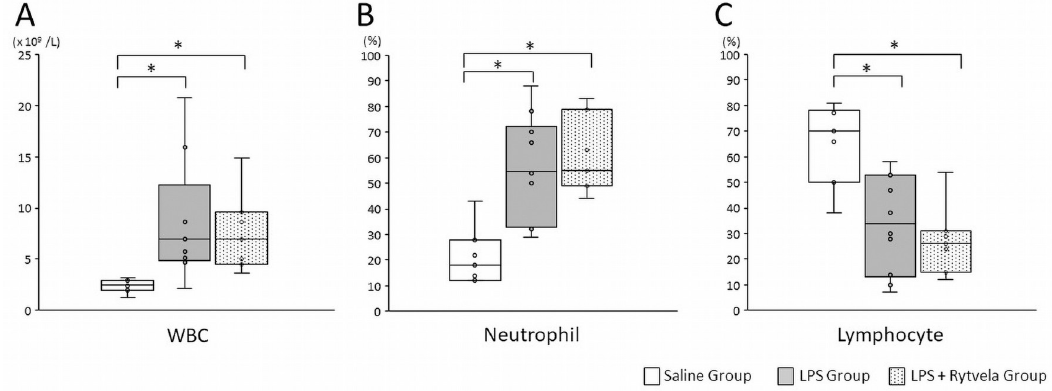
Fig 9. Haematological assessments. Plots show median, 25th, and 75th percentile ranges as boxes and 5th to 95th percentile as error bars. Intra-amniotic injection of LPS affected A , total white blood cell (WBC) counts; B , ratio of neutrophil; C , ratio of lymphocyte from cord blood. LPS, lipopolysaccharide. n = 7–9 animals/group.